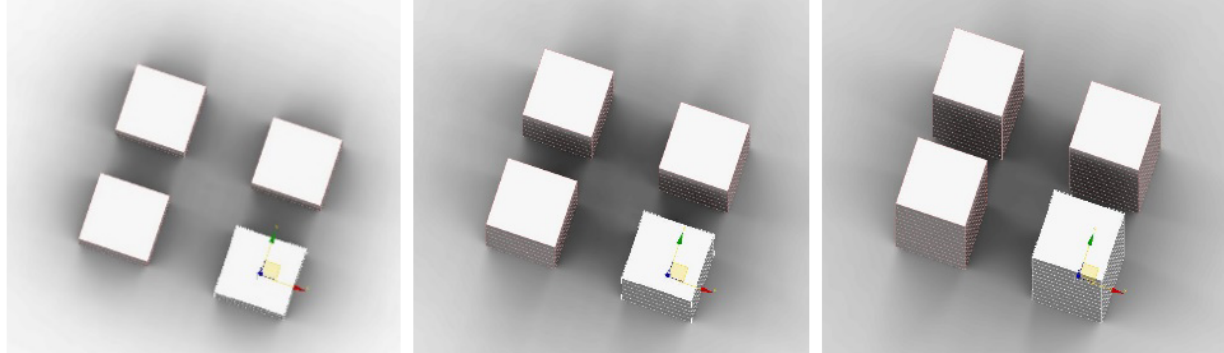
Figure 2. This figure shows a sequence of screen-grabs of four boxes (buildings) with their height parameter changed. As the box’s height parameter is increased, the shadows become darker representing a lower SVF reading (less sky is visible where the shadow is